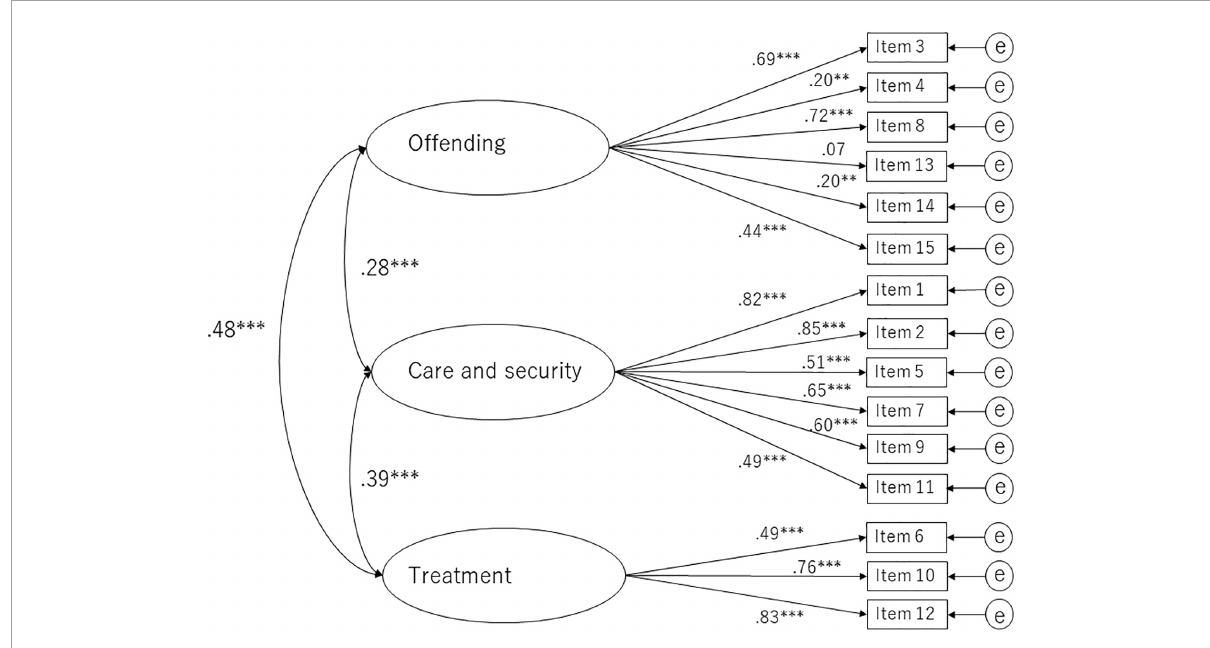
FIGURE1 Confirmatory factor analysis based on the original three-dimensional structure of SACS. ∗∗ p < 0.01; ∗∗∗ p <